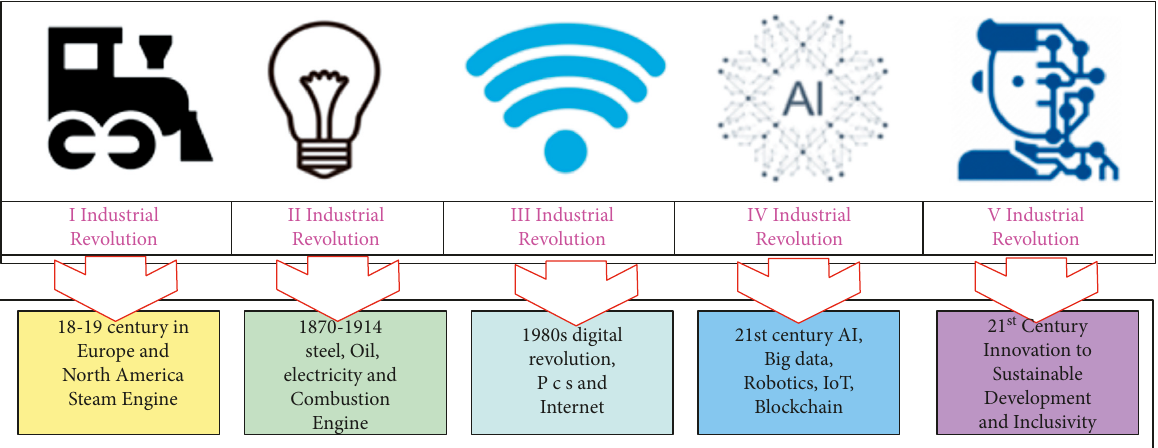
Figure 1: Transformation of the industrial